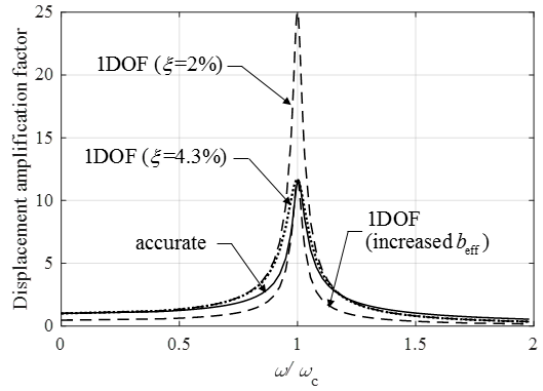
Figure 15. Displacement amplification factor of an infinitely long orthotropic plate ( ξ = 2%) without torsional stiffness subjected to a trigonometrical line load (solid line) and those of one degree of freedom (1DOF) systems. Dashed lines give the response calculated for two different effective widths ( ξ = 2%), while the dotted line is obtained from a replacement damping ratio ξ repl =